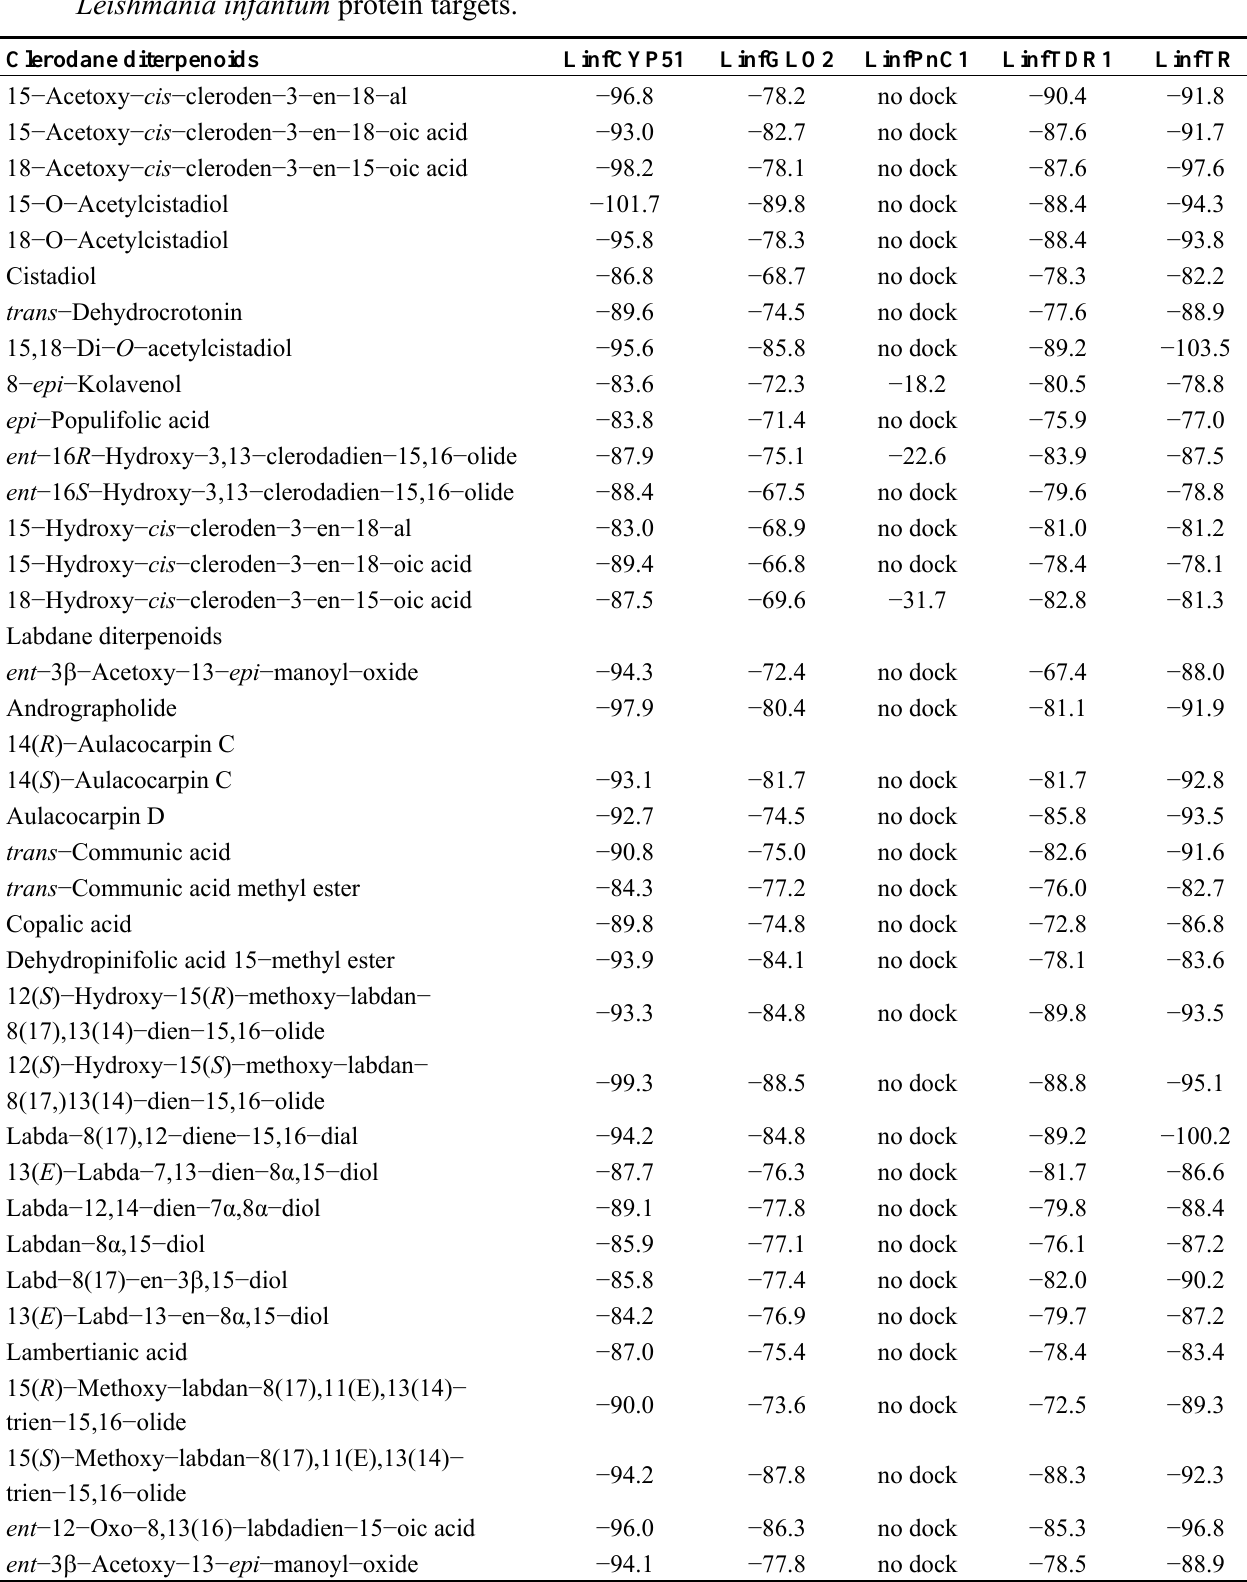
Table 21. MolDock docking energies (kJ/mol) of clerodane and labdane diterpenoids with Leishmania infantum protein